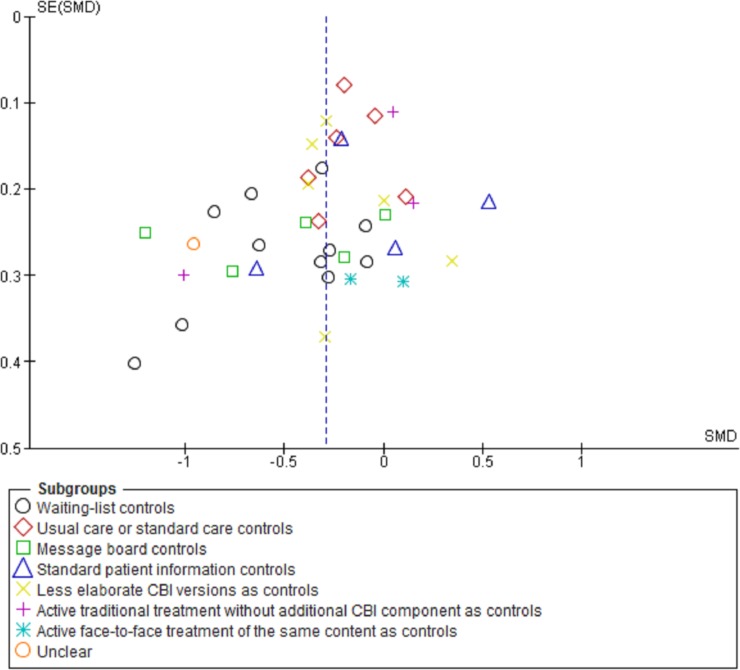
Funnel plot for symptom severity scores post treatment by various types of control groups.SE = Standard Error, SMD = Standardized Mean Difference. Comments: The meta-analysis presented here included the results for active comparisons (not the passive ones) from Trompetter et al. (2015) and Dear et al. (2015) to avoid double entries. Online discussion was facilitated for control group participants while being on a waiting list for receiving the experimental CBI.